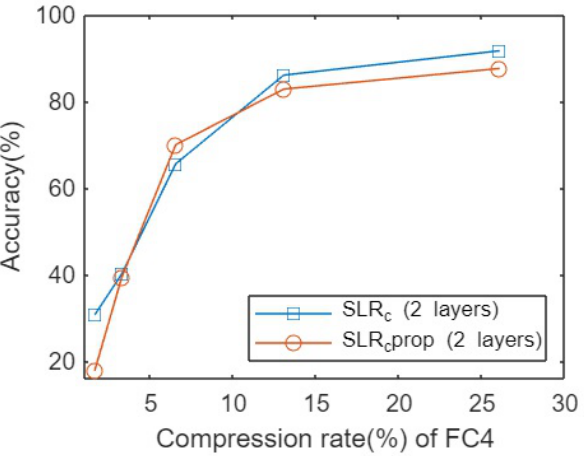
Figure 4. Accuracies for pruning Lenet5 network on MNIST dataset for different compression rates.